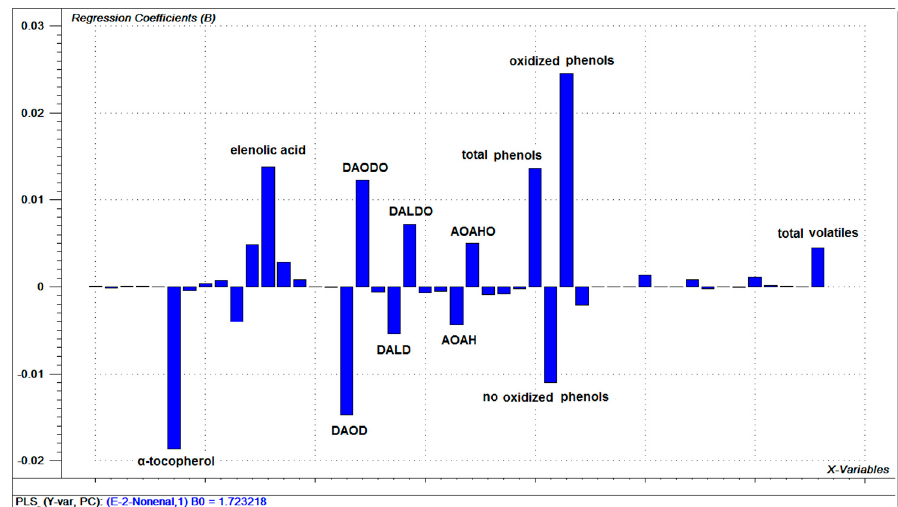
Figure 5. Regression vector of the PLS model for relation between oils variables and ( E )-2-nonenal.